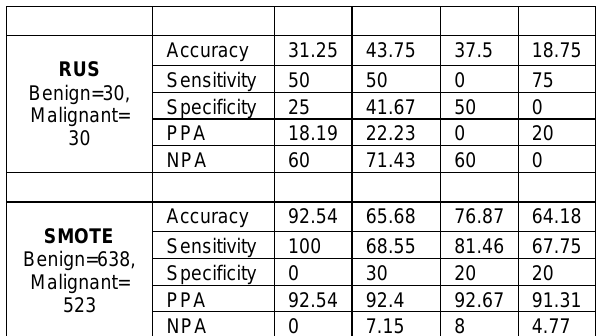
Table 4(a) Result for target Variable Hinselmann